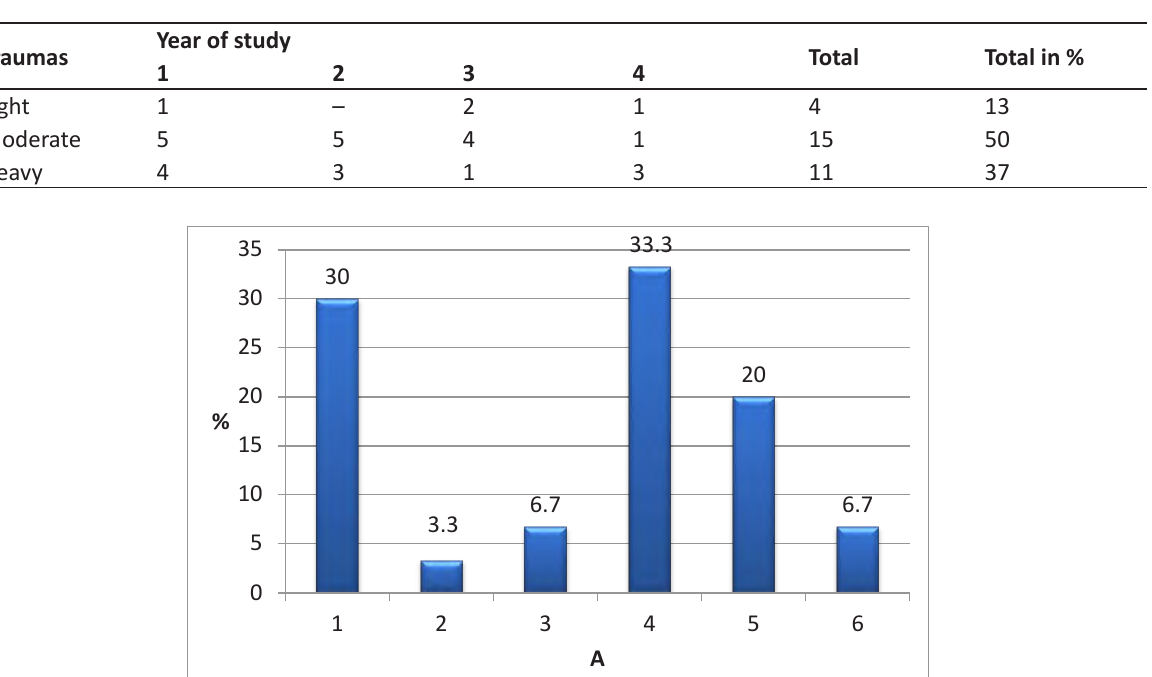
Table 3. Characteristic of traumas by heaviness of their impact on organism (quantity)